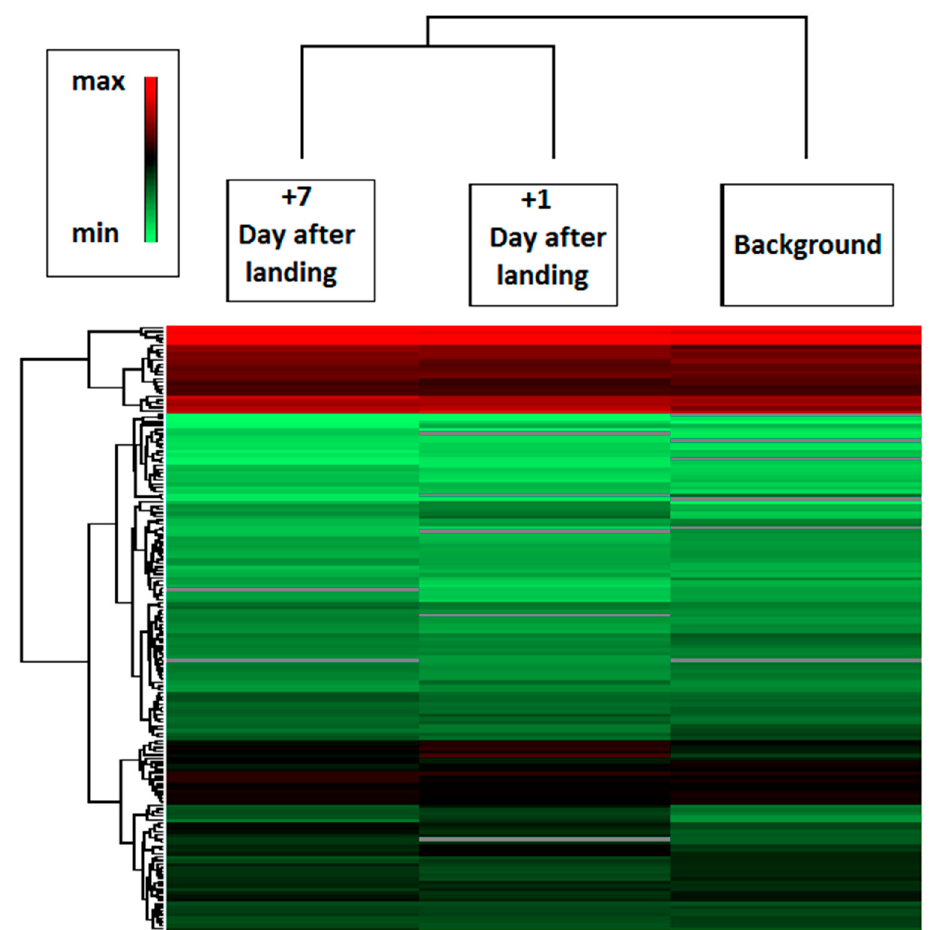
Figure 2. The heat map analysis represents the hierarchical clustering of samples set before and after the spaceflight. Hierarchical clustering of proteomic composition was performed using logarithmized label-free quantification (LFQ) intensities. The strength of the colors indicates the relative abundance of the protein in different groups.